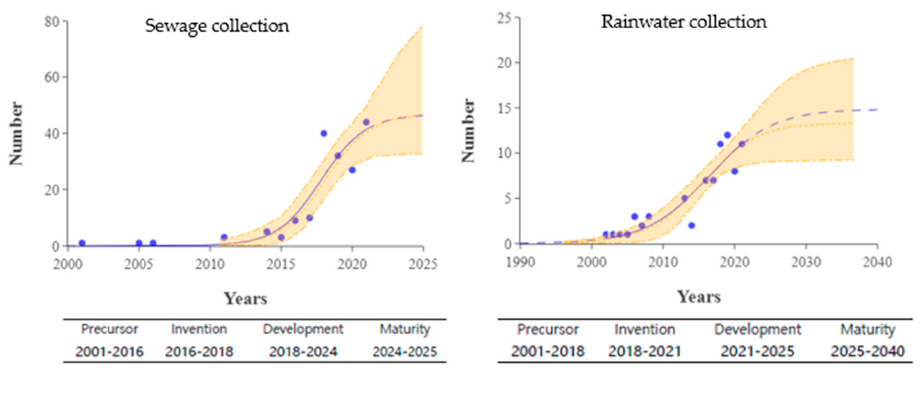
Figure 17. S-curves for collection in patents.